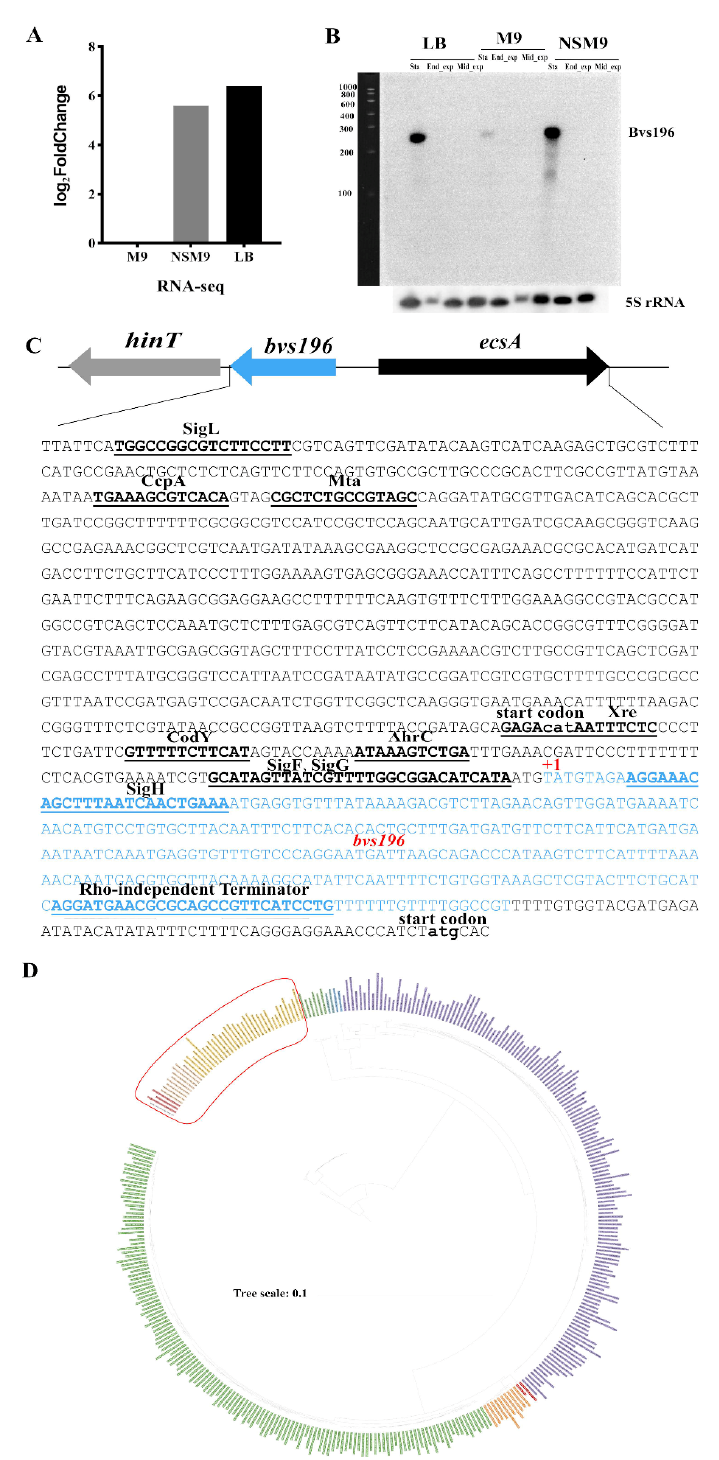
Figure 1. Basic characteristics of Bvs196. ( A ) The expression levels of bvs196 at the stationary phase in M9, NSM9, and LB compared to M9 medium based on RNA-Seq analysis in B. velezensis strain PEBA20. ( B ) Transcript levels of bvs196 at different times in M9, NSM9, and LB medium detected by Northern blot. Sta, the stationary phase; End_exp, end of the exponential phase; Mid_exp, middle of the exponential phase. ( C ) The genes situated next to bvs196 and the nucleotide sequence of bvs196 , all putative regulatory binding sites, were marked. ( D ) Phylogeny tree of 253 Bacillus genomes. The tree was generated based on an alignment of the whole genomes using REALPHY. The red frame included strains missing the 3 (cid:48) ends of the bvs196